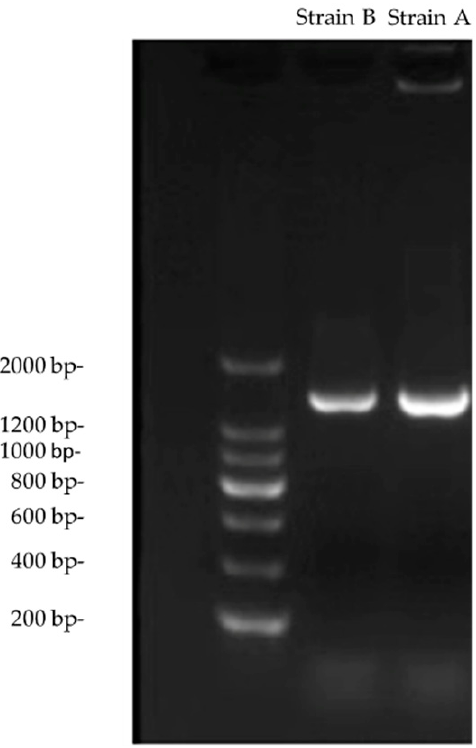
Figure 1. PCR amplification and gel electrophoresis of strains A and B. The 16S rRNA sequences (GenBank accession number: OM665406; OM665407) of the